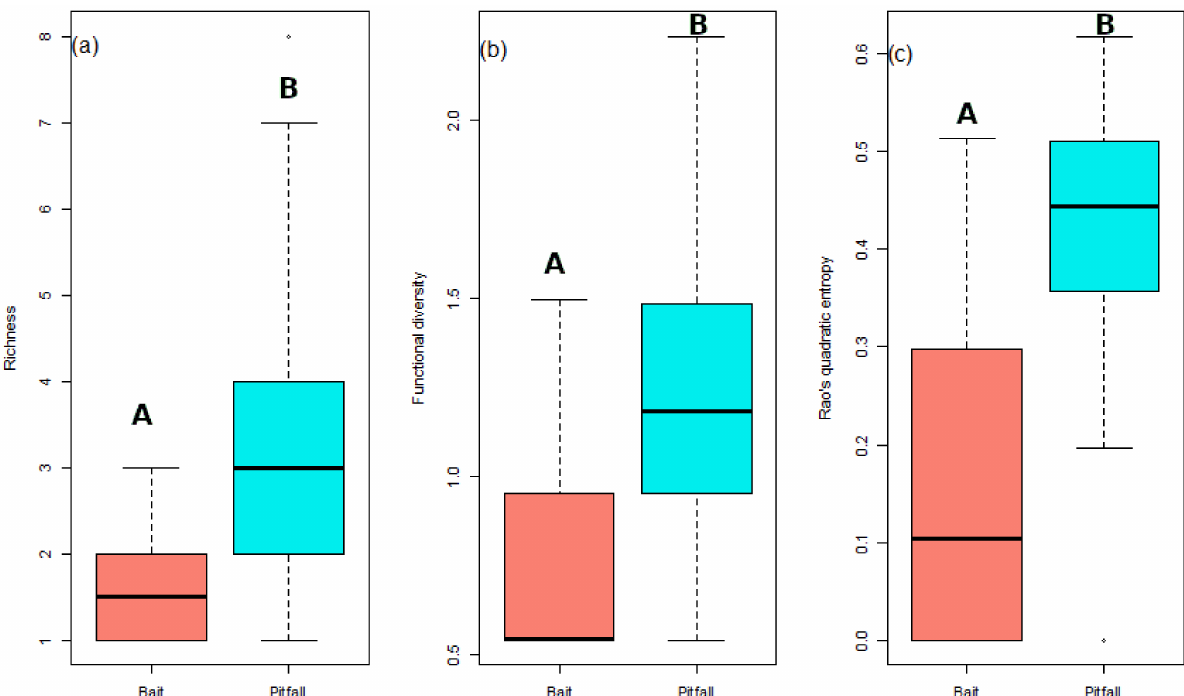
Figure 4. Comparison between bait and pitfall traps of ( a ) species richness; ( b ) functional diversity; and ( c ) Rao’s quadratic entropy. Significant differences are represented using different successive letters (e.g., A & B) for p -value < 0.001.